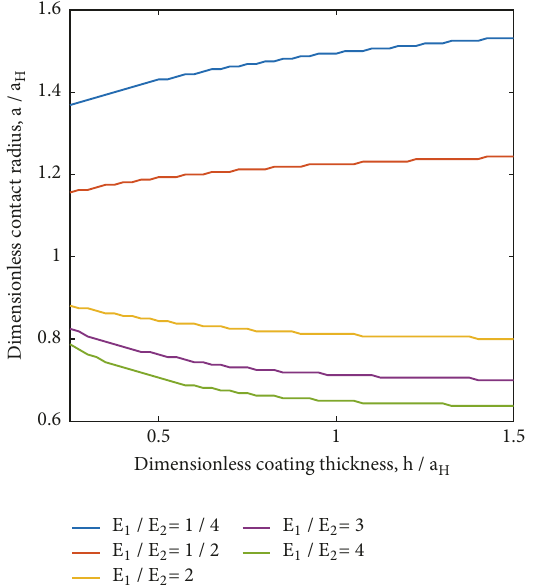
Figure 8: Influence of coating thickness on the dimensionless contact radius 𝑎/𝑎 𝐻 .